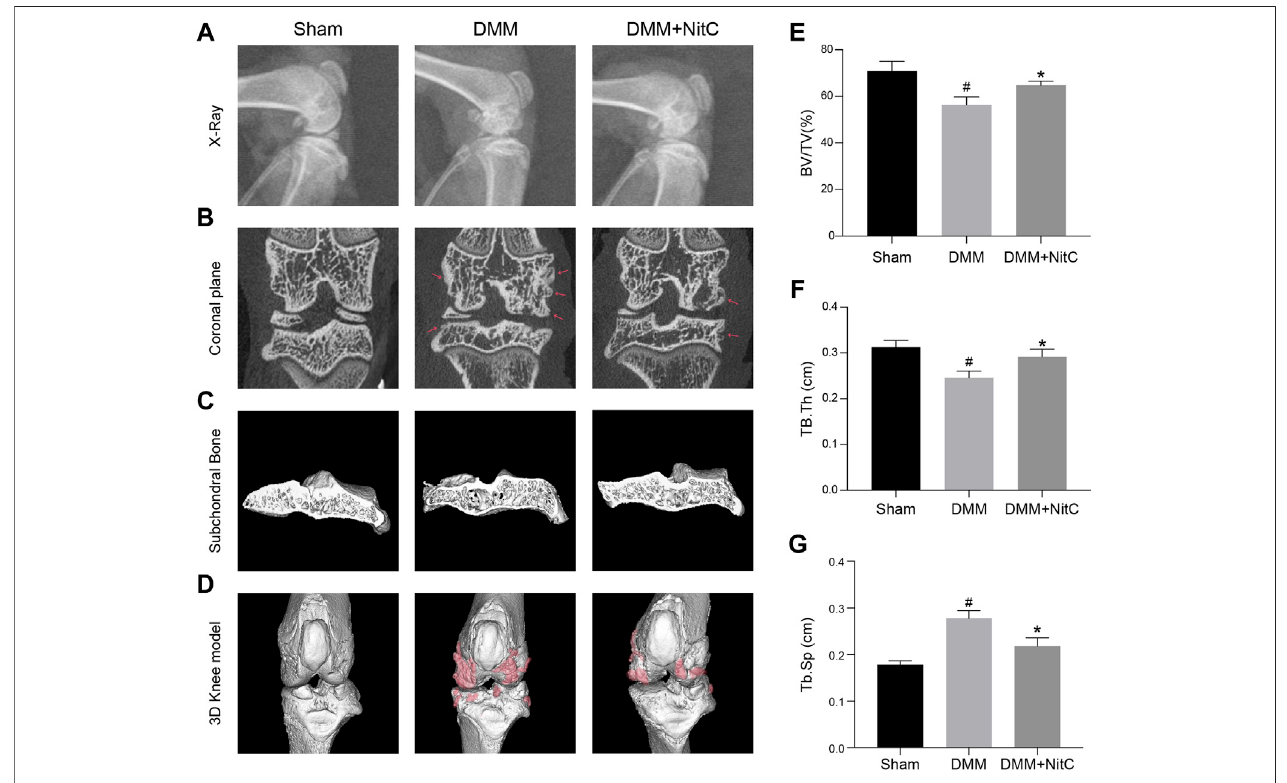
FIGURE 8 | Radiological assessment of NitC impact on DMM rats. (A) Representative images of rat knees X-ray scanning. The treatment was performed as previouslydescribedin MethodsandMaterials . (B) Thecoronalplaneofratknees.Theredarrowshowedosteophyteformation. (C) Subchondralboneineachgroup. (D) Reconstruction of 3D rat knee models. IMALYTICS Preclinical 2.1 software was used to evaluate BV/TV (E) , Tb.Th (F) , and Tb.Sp (G) . #p < 0.05 versus the control group. p p < 0.05 versus the model group.